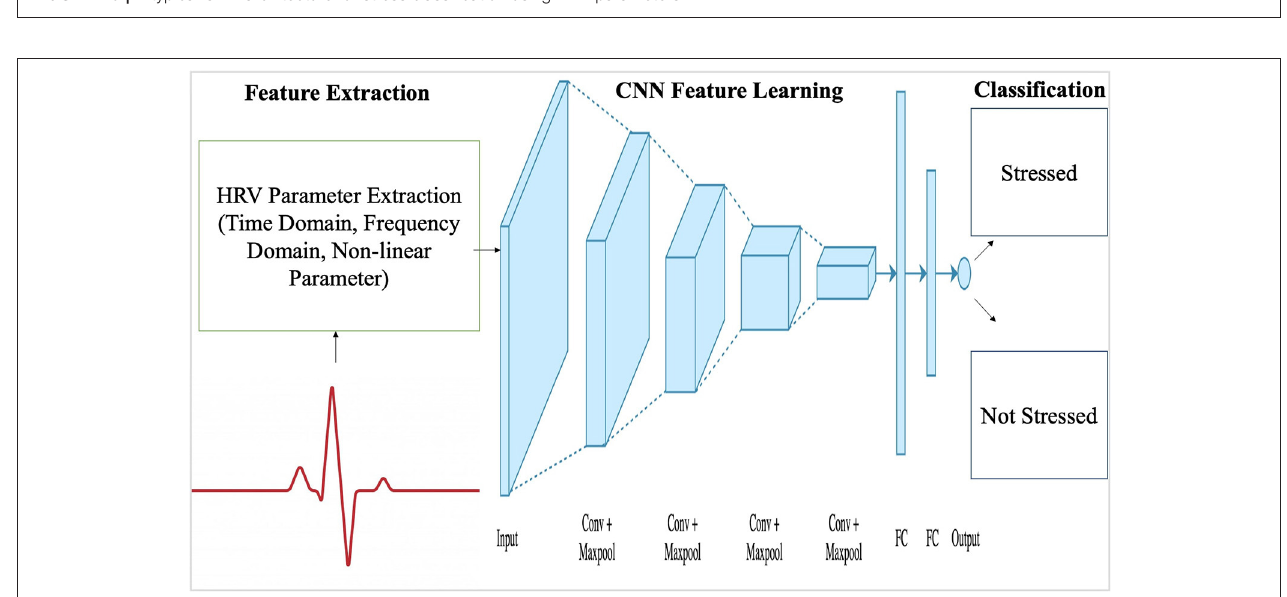
FIGURE 10 | A typical CNN architecture for stress classification using HRV parameters.